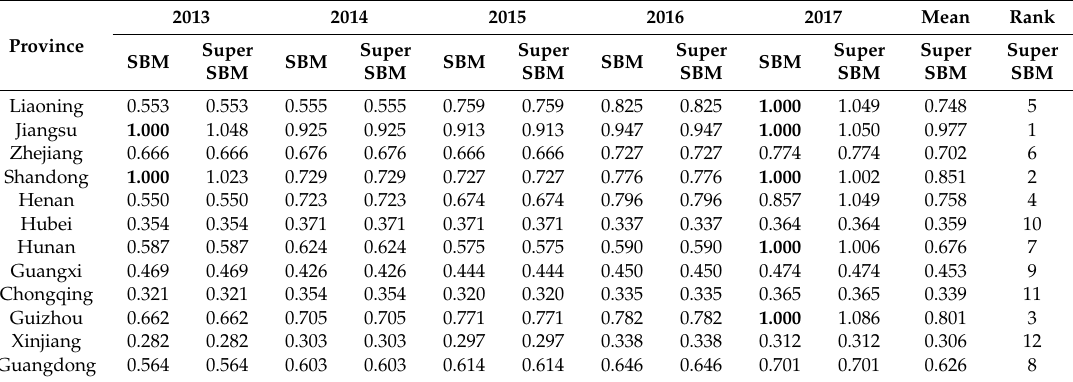
Table 3. Values for the static carbon emissions e ffi ciency index of the logistics industry (SLCEI) for the pilot regions under SBM and Super-SBM